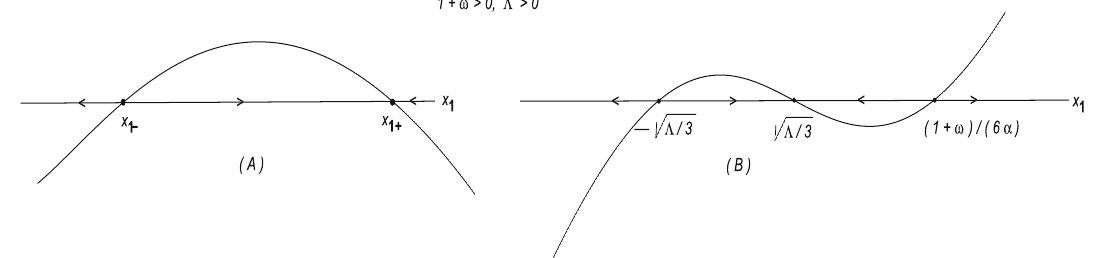
Fig. 20 The curve determining the fixed points ˙ x 1 = 0 for a spatially flat universe: A for constant viscosity coefficient ˜ ξ while B for varying viscosity coefficient ˜ ξ = α x 2 . It is understood that the vertical axis represent ˙ x 1 which is not shown for convenience The parameter μ has the critical value, zero, when ˜ ξ 2 3 − ( 1 + ω) 2